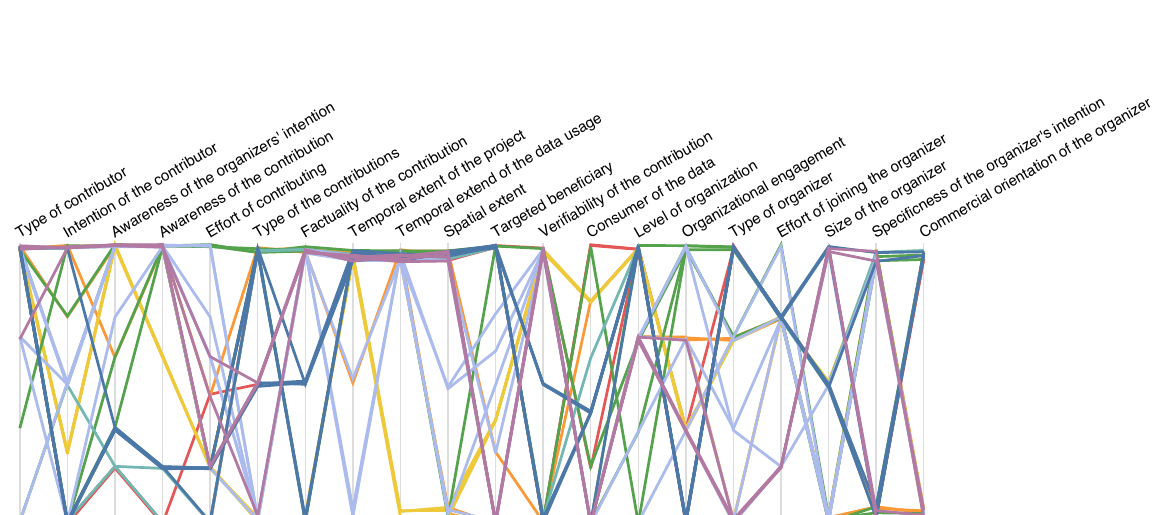
Figure 3. Parallel coordinates graph of Geographical Shared Data Sources (GSDSs). The legend for the categories can be found in Figure 2. The data has been slightly randomized.